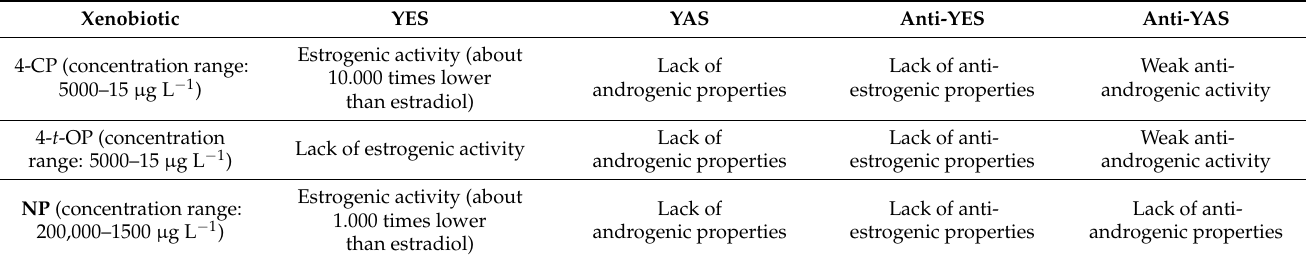
Table 3. Activity of test xenobiotics in the XenoScreen YES/YAS Endocrine Disruptor Assay 1 .